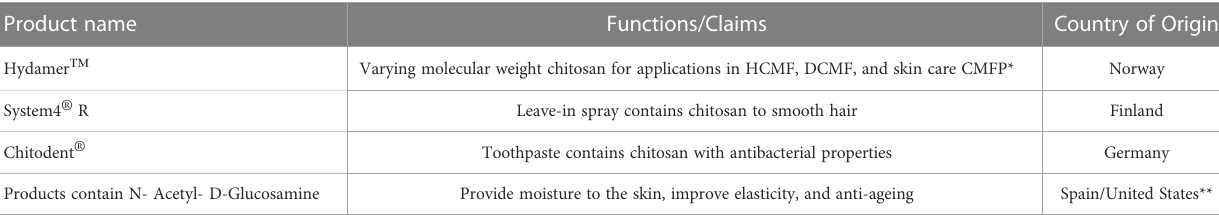
TABLE 3 Examples of manufacturing industries of crustacean-sourced chitosan